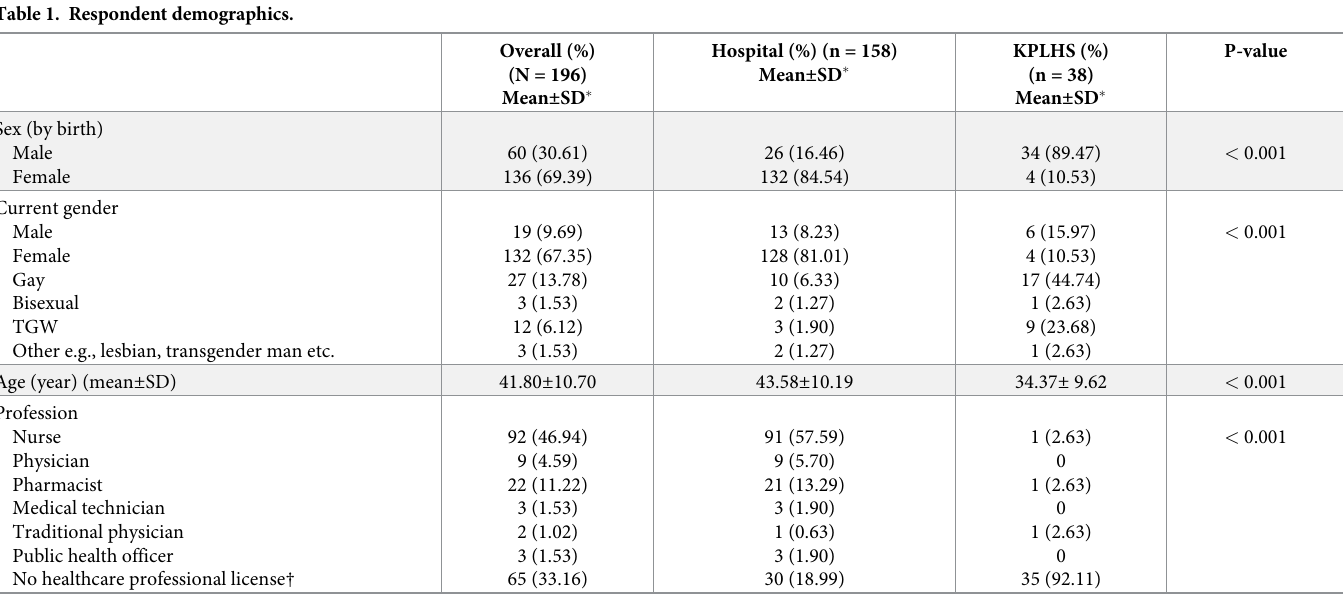
Table 1. Respondent demographics.